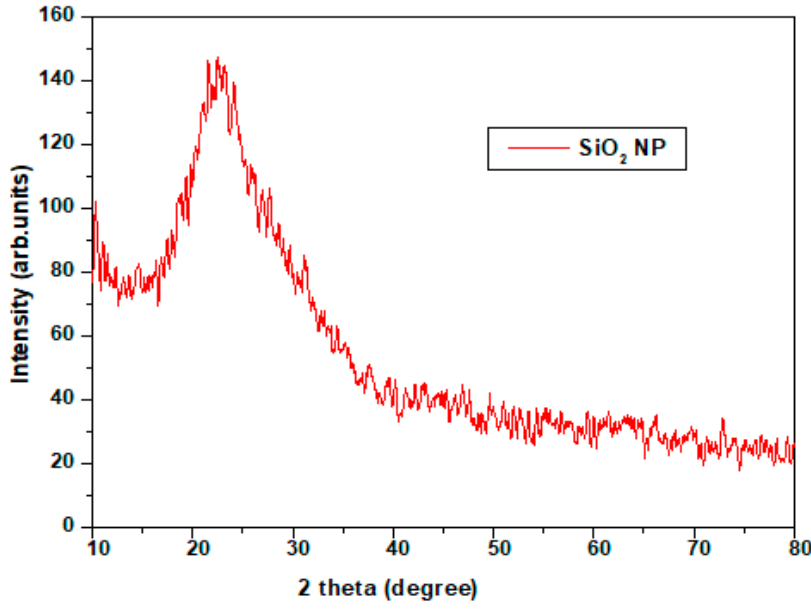
Figure A2. X-ray diffraction pattern of SiO 2 NPs.